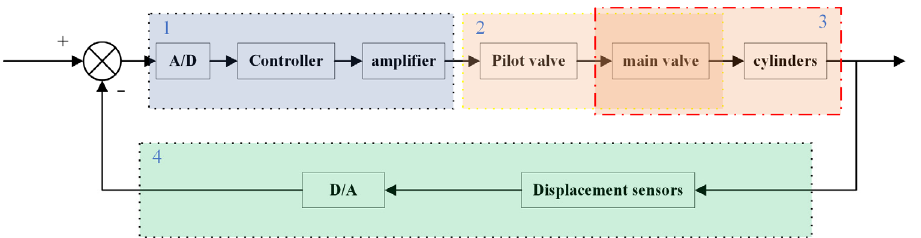
Figure 3. The principle diagram of electro-hydraulic proportional system.